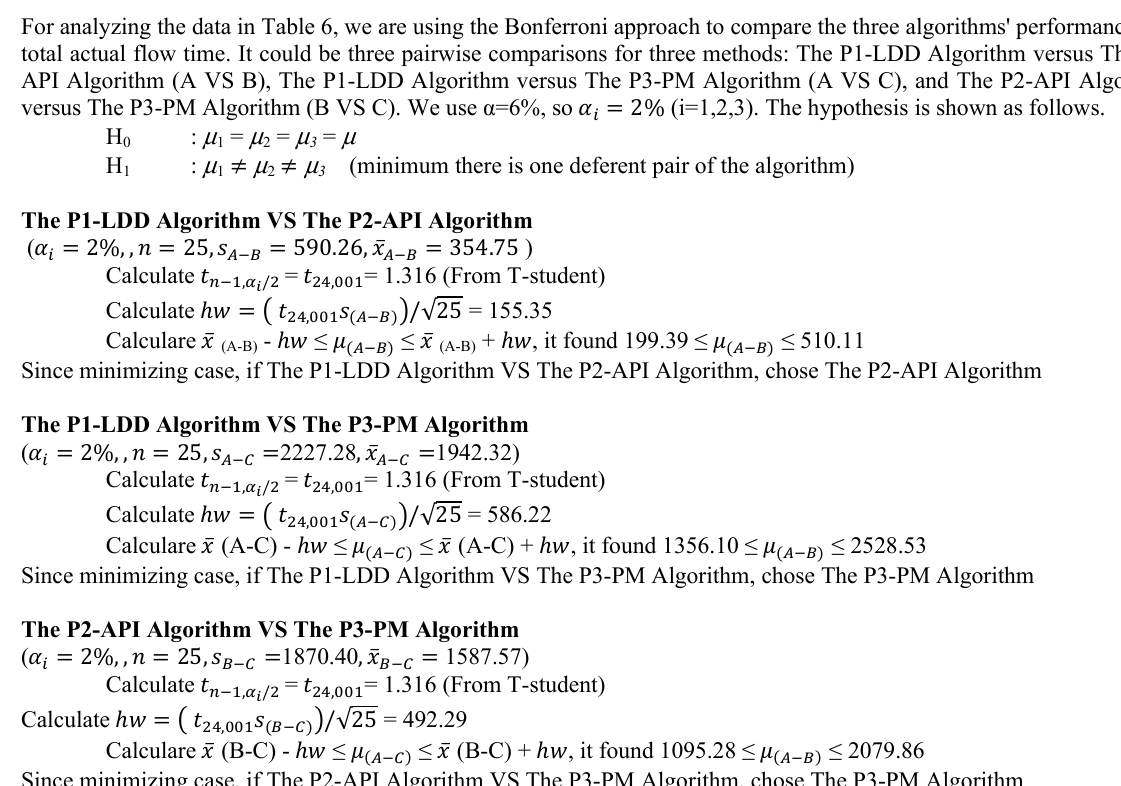
API Algorithm (A VS B), The P1-LDD Algorithm versus The P3-PM Algorithm (A VS C), and The P2-API Algorithm versus The P3-PM Algorithm (B VS C). We use α =6%, so 𝛼